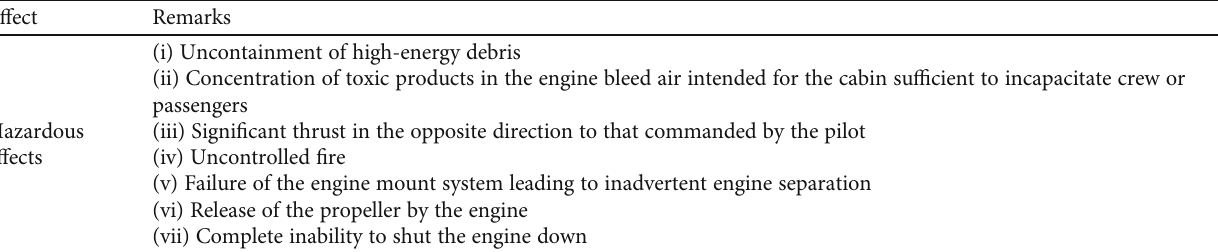
Table 1: Hazardous engine e ff